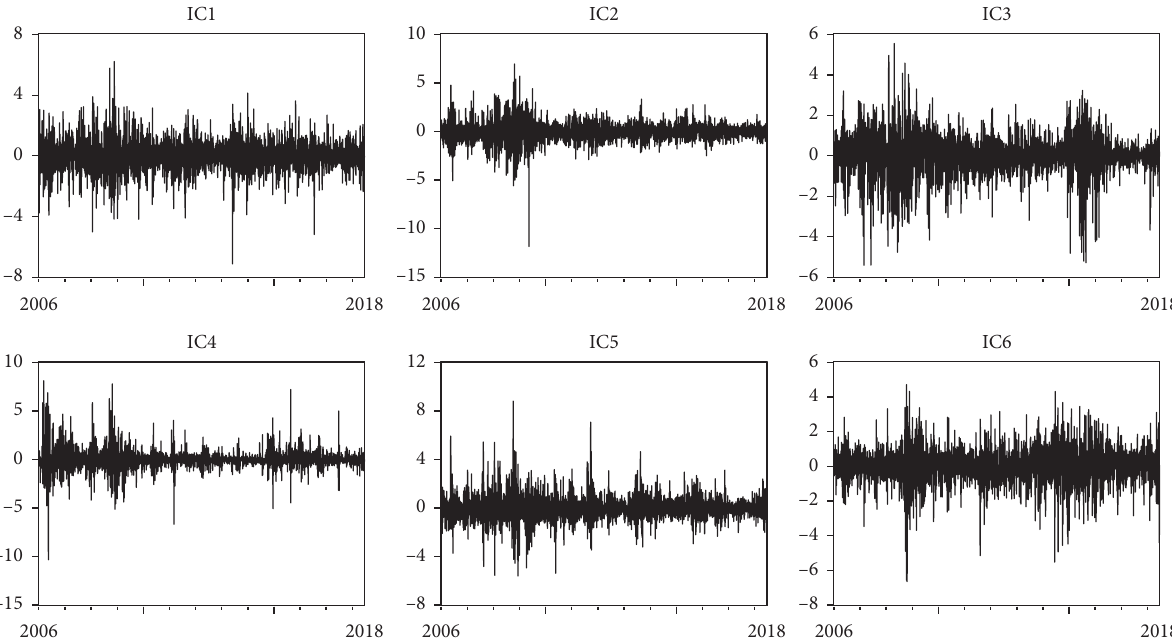
Figure 8: The time series of IC